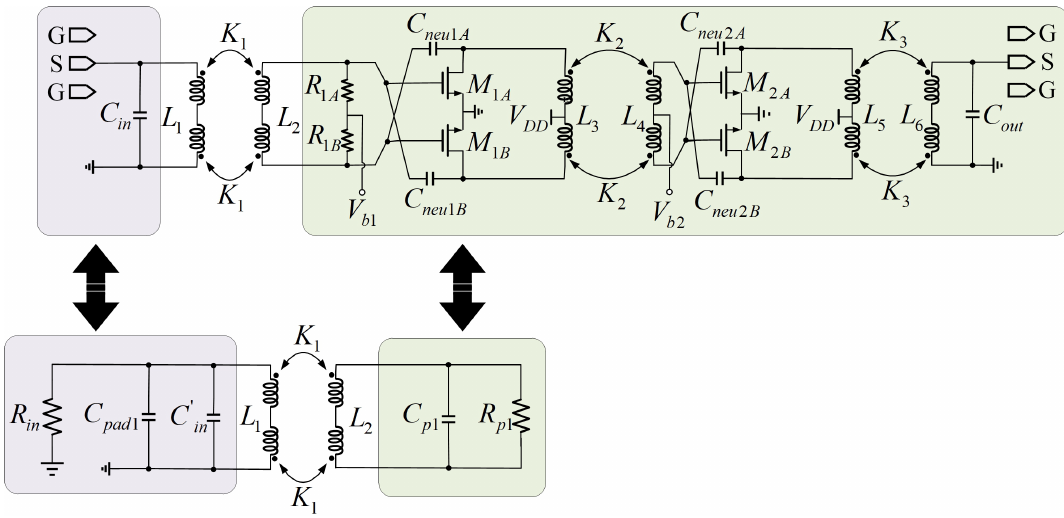
Figure 11. Schematic of input matching network.